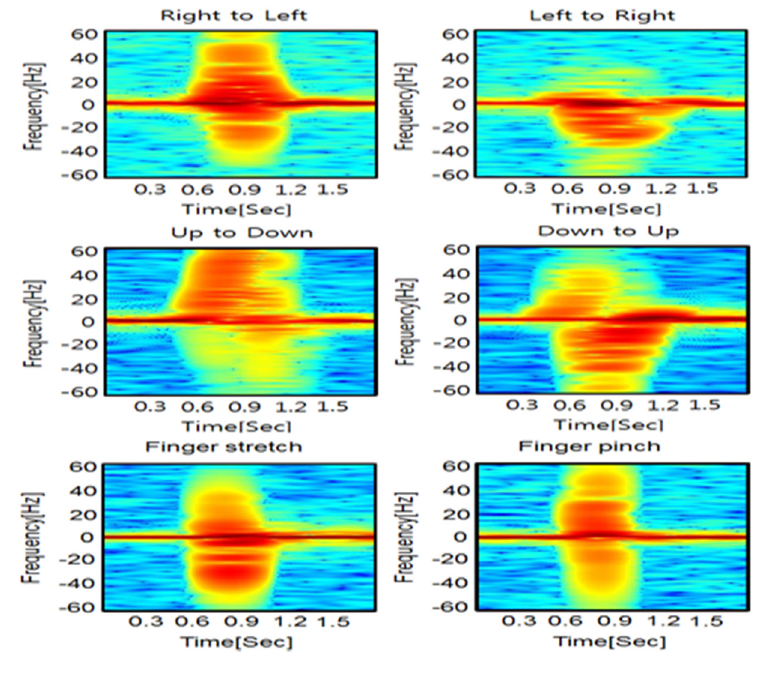
Figure 6. Spectrograms of each hand gesture.